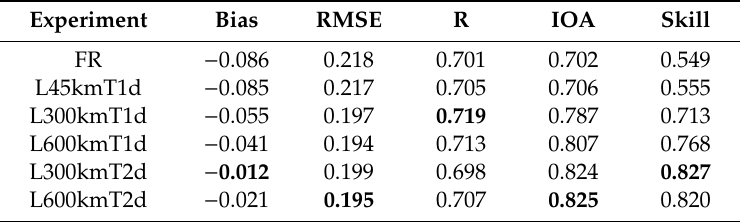
Table 2. Same as Table 1, except for 27 November 2016 only and 7311 pairs of simulated and observed AODs used for calculating the metrics.